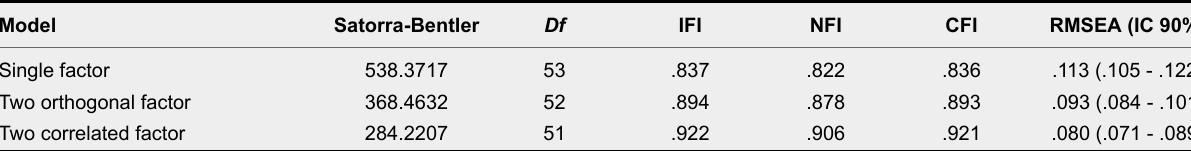
Confirmatory Factor Models -Verification of the Structure of Mental Health and Mental Illness.